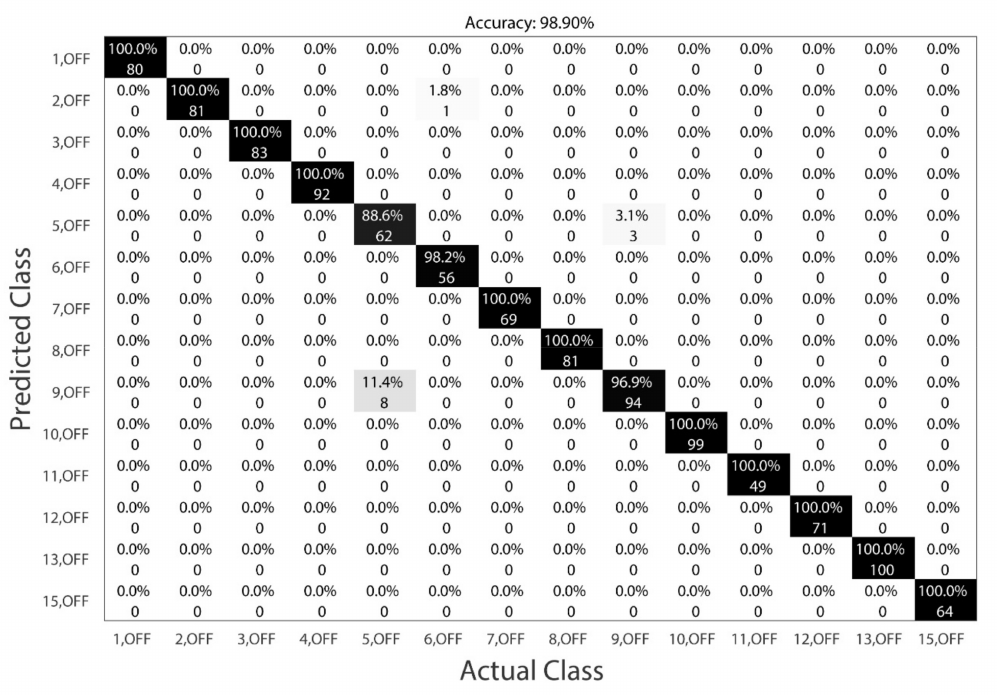
Figure 12. Confusion matrix for the recognition of switching-on events of the tested appliances using the proposed method. Only events detected by the detection algorithm were the subject of